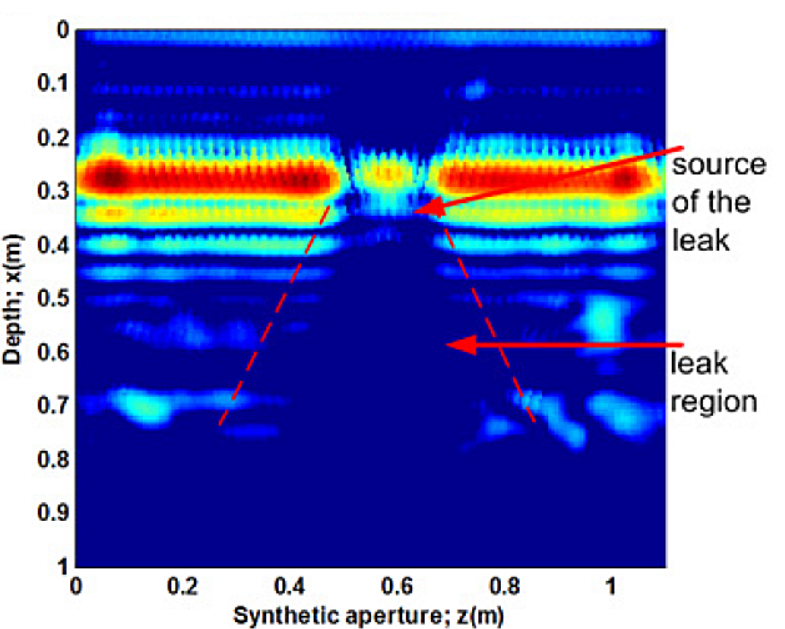
Figure 13. The GPR image of a leaking water pipeline. Reprinted from NDT & E International, Volume 47, Demirci, S.; Yigit, E.; Eskidemir, I.H.; Ozdemir, C. Ground Penetrating Radar Imaging of Water Leaks from Buried Pipes Based on Back-projection Method, Page 35–42, Year 2012 with permission from Elsevier